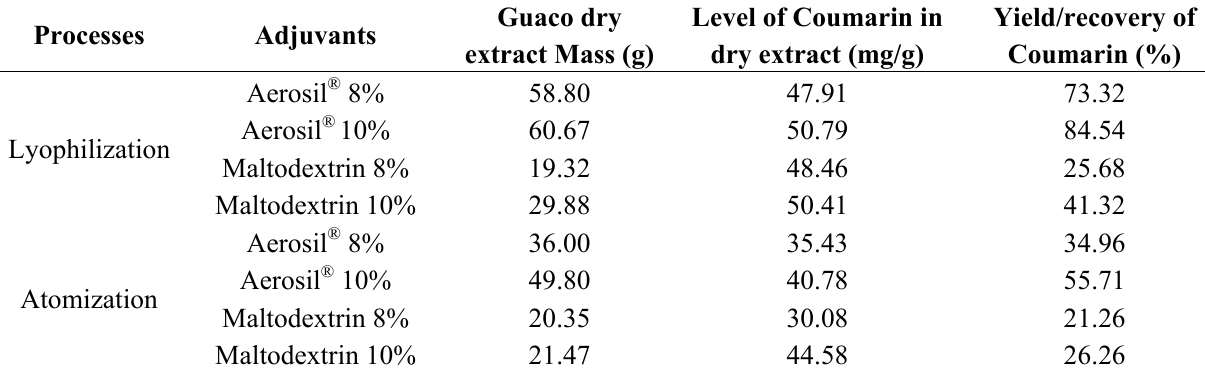
Table 2. Guaco dry extract Mass (g), coumarin level (mg/g of dry extract) of the lyophilized and atomized dried extracts samples using Aerosil ® 8% and 10% or maltodextrin 8% as adjuvants, and the coumarin recovery/yield percentage (%) in each case was in accordance to the calculations obtained from the Equations 1 and 2.